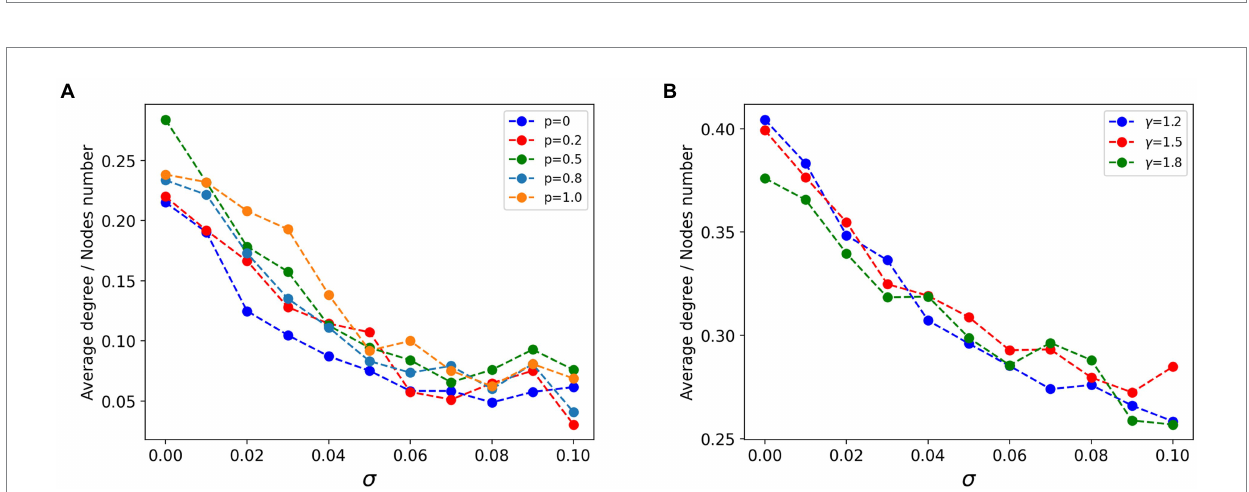
FIGURE 5 Curves of the relationship between the average degree of lesion node groups and excitatory heterogeneity in the functional network. (A) In the strongly connected network of lesion nodes, the higher the node heterogeneity, the smaller the average degree of nodes, and the regular connection ( p = 0), small world connection (0 < p < 1) and random connection ( p = 1) show the same law. (B) In the scale-free strong connection network of focal nodes ( γ is the power-law exponent of scale-free network), the higher the node heterogeneity, the smaller the average degree of nodes, and the scale- free network structure pattern has little